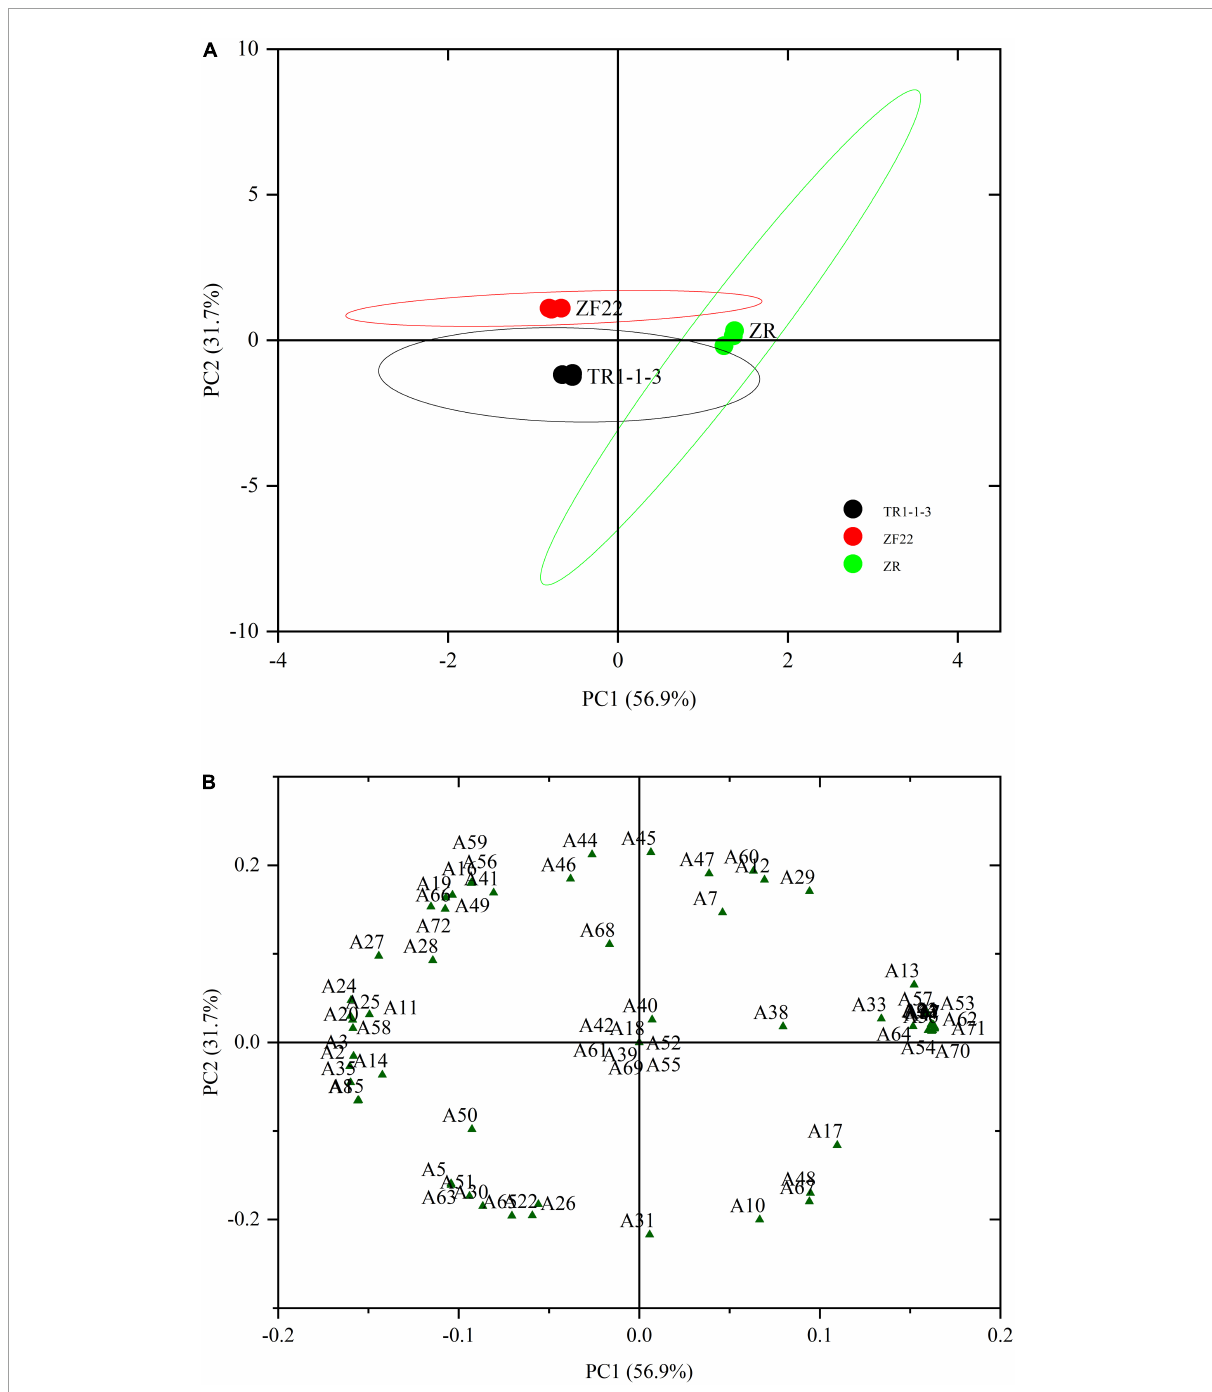
FIGURE4 Principal component analysis (PCA) plots of volatile compounds in fermented sausages stored for 30 days. (A) PCA score plot depicting the distribution of samples for the first two principal components (PC1 and PC2). (B) PCA loading plot depicting the distribution of the 72 volatile compounds for the first two main components (PC1 and PC2). A1–A72 are the types of volatiles.